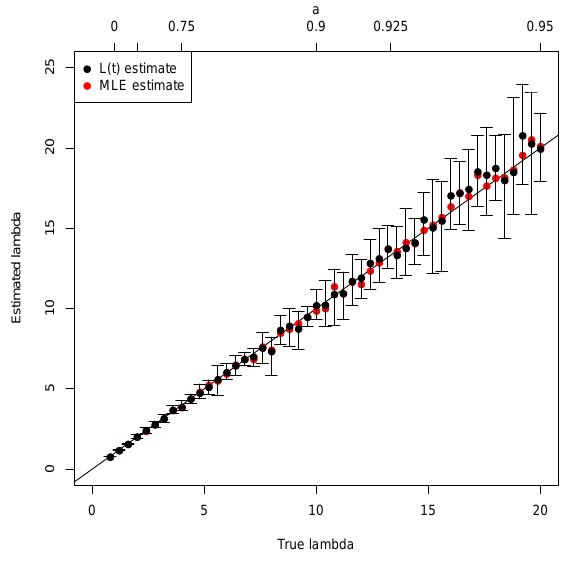
Fig. 3. Bias estimates of λ from an MLE computation ˆ λ (red circles) and mean “lifetime” computation ¯ λ (black circles). The bars around the ¯ λ estimates indicate the 5th and 95th quantiles of L 2 (t) varia- tions of AR(1) realizations. See text for formulas. The first diagonal is indicated for reference. The upper axis indicates variations of a (as in Eq.